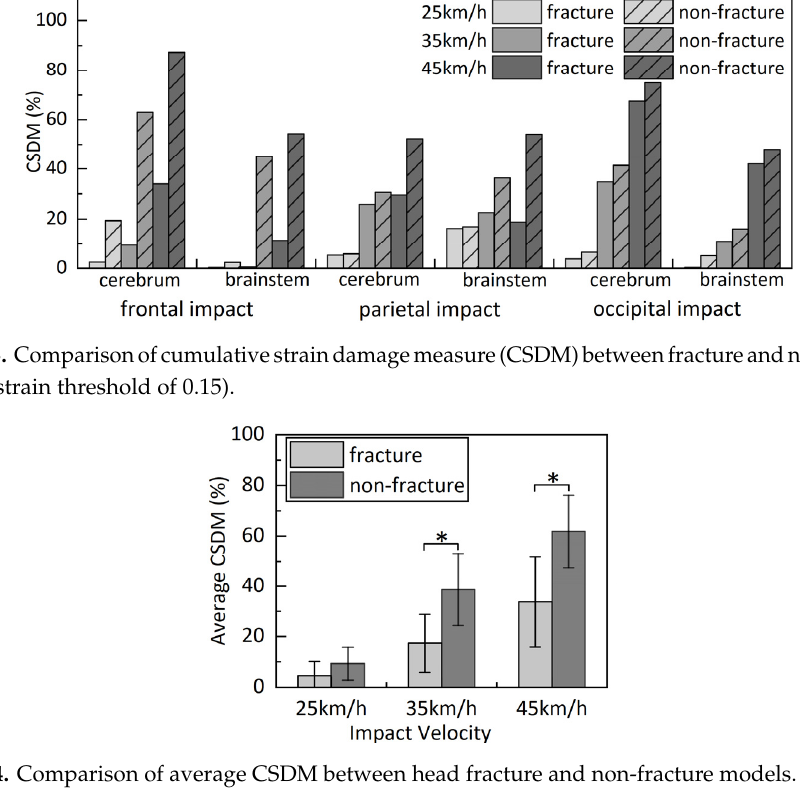
Figure 14. Comparison of average CSDM between head fracture and non-fracture models. Shown are average CSDM and standard deviation of the white matter of the cerebrum and brainstem for three impact velocities. Asterisks on fracture and non-fracture models indicate the significant level of skull fracture effect on CSDMs at each velocity; * denotes significant effect, that is, p ≤ 0.05.